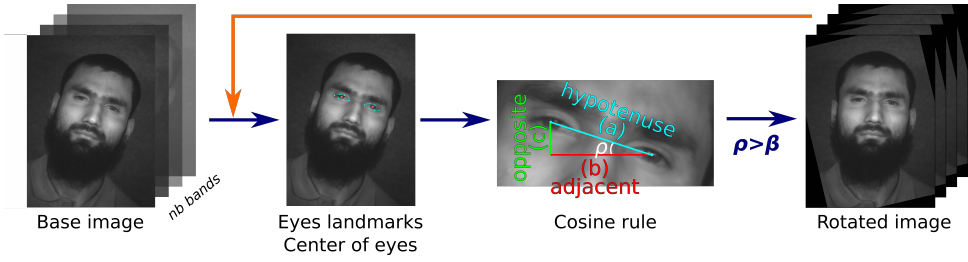
Figure 2. Face alignment process.